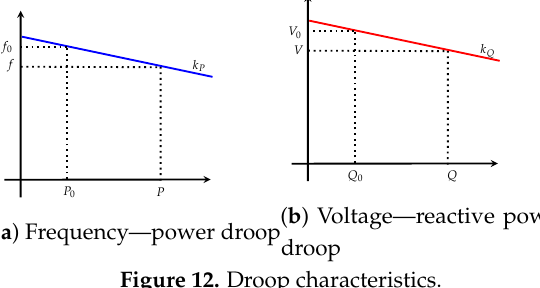
Figure 12. Droop characteristics.